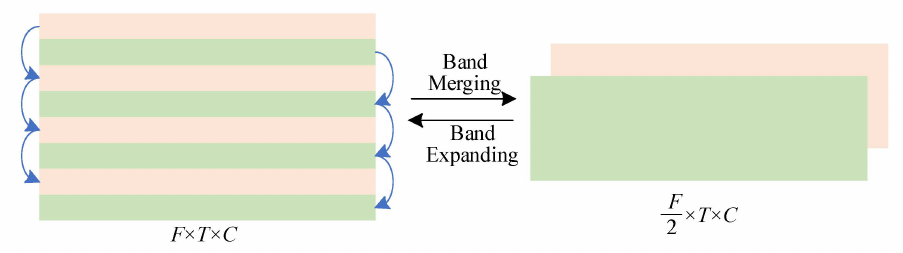
Figure 4. The illustration of band merging and expanding